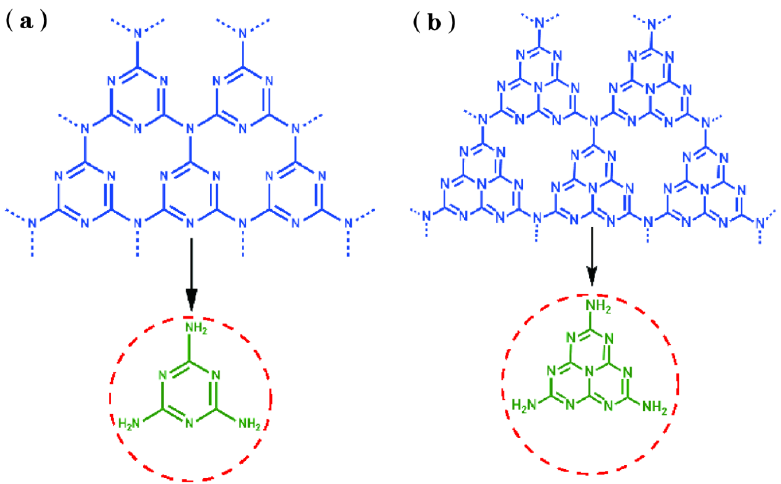
Figure 3. ( a )Triazine and ( b ) tris − s − triazine (heptazine) structures of g − C 3 N 4